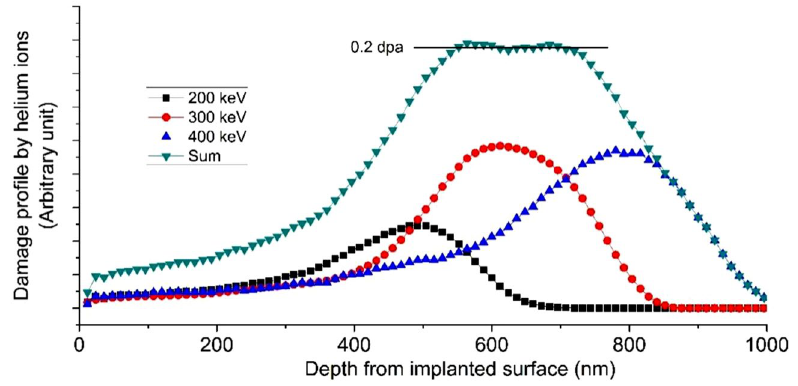
Figure 3. SRIM estimated damage depth profile for helium ion implantation in steel. The energies of helium ions used were 200 keV, 300 keV and 400 keV.